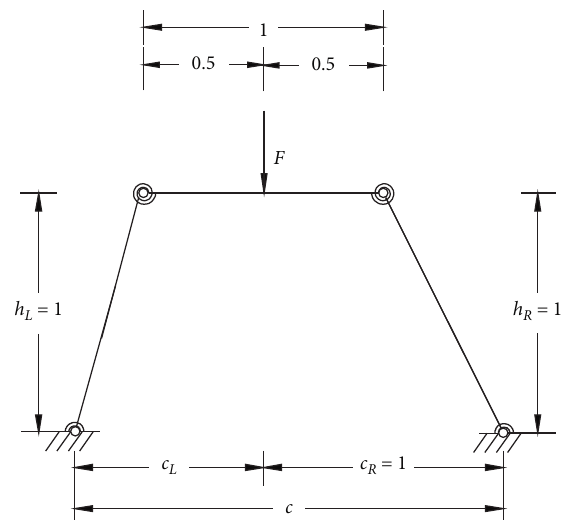
Figure 6: Geometry of the asymmetric portal frame adopted in the FE analysis with c R ≠ c L